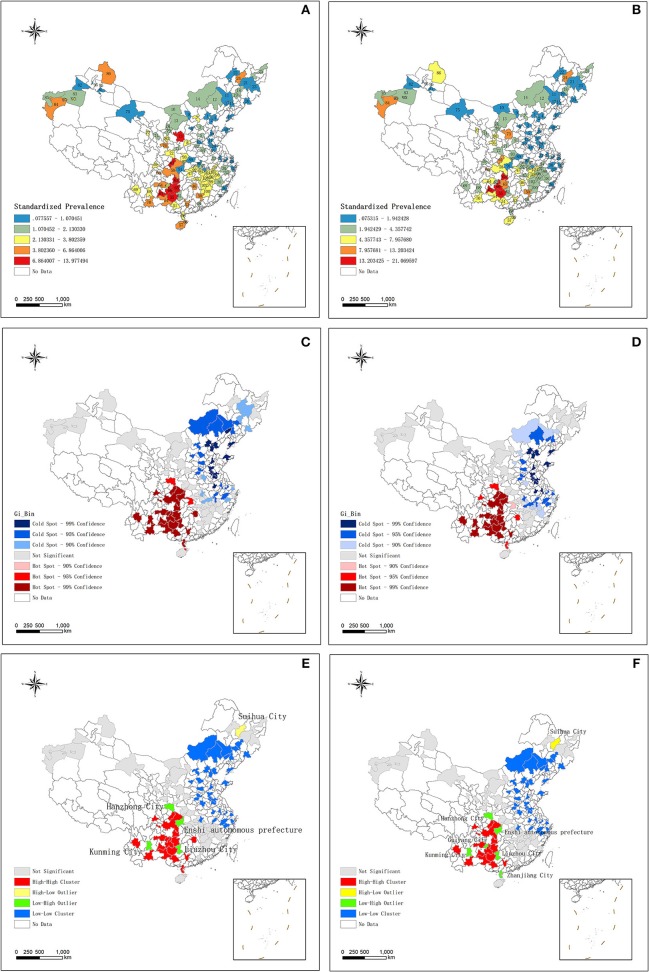
(A) The distribution of short stature standardized prevalence according to WHO growth reference. (B) The distribution of short stature standardized prevalence according to China growth reference. (C) The result of Hotspot Getis-Ord, Gi* about short stature according to WHO growth reference. (D) The result of Hotspot Getis-Ord, Gi* about short stature according to China growth reference. (E) The results of Anselin Local Moran's I about short stature according to WHO growth reference. (F) The results of Anselin Local Moran's I about short stature according to China growth reference. WHO, World Health Organization.